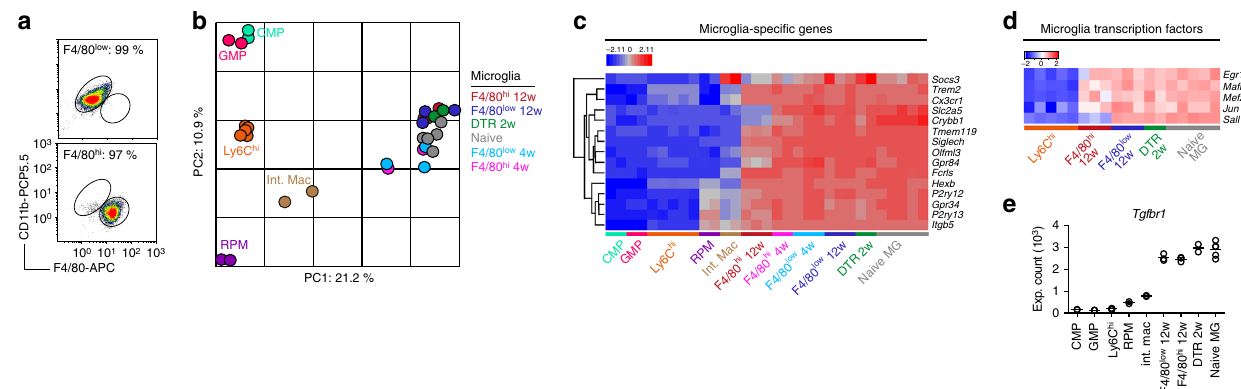
Fig. 4 Gene expression pro fi le of repopulating microglia/macrophages. a FACS purities of sorted F4/80 low and F4/80 hi populations. b PCA of microarray expression pro fi les. n (biological + technical) = 2 GMP, 2 CMP, 3 + 2 Ly6C hi , 2 RPM, 2 int. mac, 3 + 2 naive microglia, 2 DTR, 3 F4/80 low 4w, 3 F4/80 low 12w, 2 F4/80 hi 4w, 3 F4/80 hi 12w. Naive microglia were sorted from Cx3cr1 CreER/ + mice that received TAM. DTR microglia were sorted from Cx3cr1 CreER/ + R26 DTR/ + mice 14 days after DT administration. F4/80 low and F4/80 hi subsets in Cx3cr1 CreER/ + R26 DTA/ + mice were sorted 4 and 12 weeks after TAM administration. RPM, int. mac, CMP, GMP, and Ly6C hi monocytes were sorted from naive mice. Int. mac. intestinal macrophage. Sorting strategies are detailed in the Methods section. Each sample represents pools of 2 – 5 mice. c Heat map ( z -scores) of expression pro fi les of 15 microglia-speci fi c genes. d Heat map ( z -scores) of expression pro fi les of microglia-speci fi c transcription factors. e Microarray expression counts of Tgfbr1 . Lines represent mean